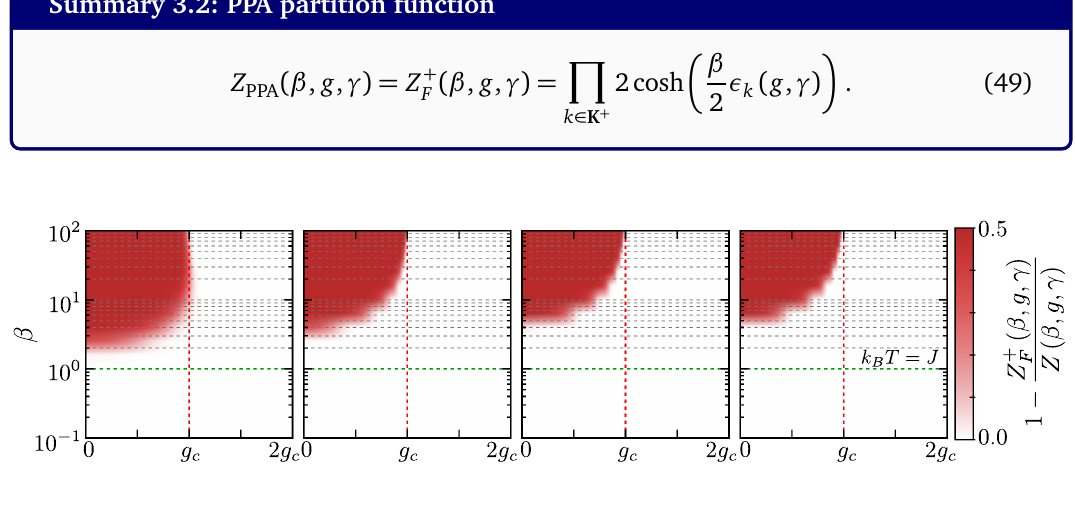
Figure 1: Comparison of the exact and PPA canonical partition functions. The ratio between the total partition function 3.1 and the PPA Eq. (49) is shown in the β - g plane for finite system size L = 50, 100, 5000, 10000, increasing from left to right (anisotropic parameter γ = 1). Significant differences appear close to the critical = 1, with the magnitude of Z + ( β , g , γ ) deviating by 50% from the exact point g = g c F partition function. The paramagnetic phase is correctly reproduced by the simplified approximation g > g while errors in the partition function are shown in red in the c ferromagnetic phase at low